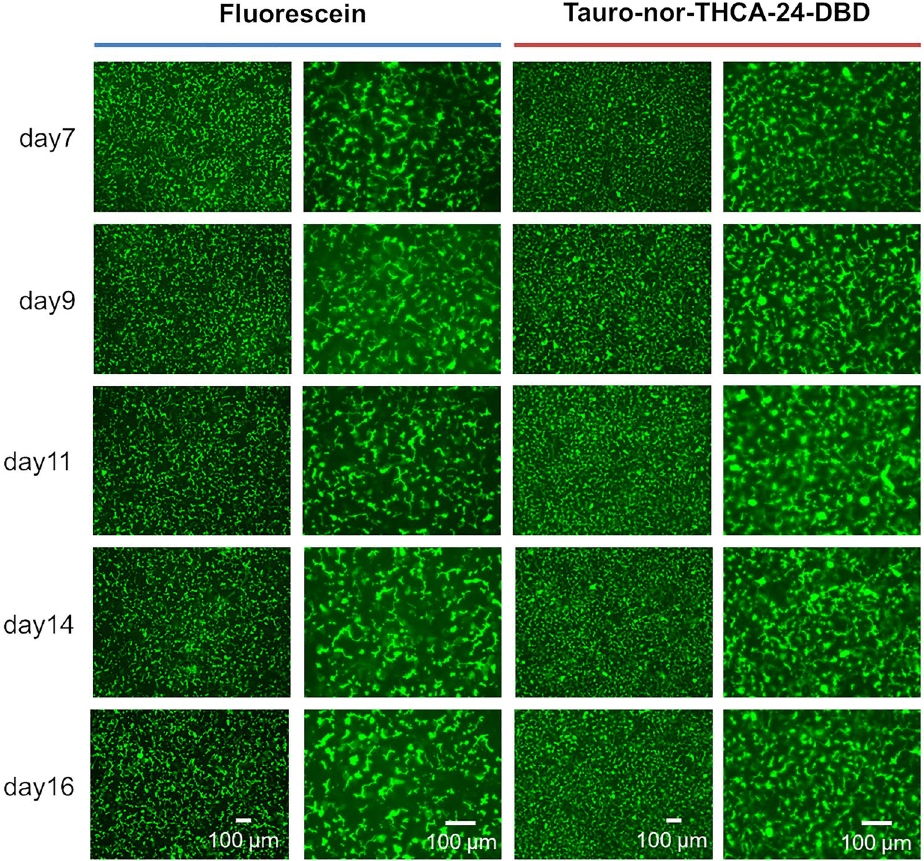
Figure 6. Accumulation of model fluorescein substrates into bile canaliculi when the stability of the canalicular efflux ability was examined. The term of sandwich culture in a maintenance medium following culture in an LTM medium for 28 days was examined to determine how long the assay is possible. Fluorescence images show fluorescein or tauro-nor-THCA-24-DBD, which accumulated in bile canaliculi when biliary efflux assay was performed on the 7th to 14th day of the sandwich